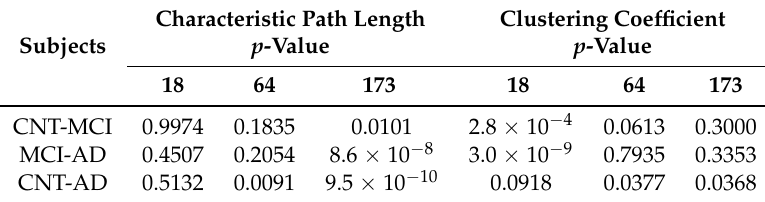
Table 2. Results of Tukey’s HSD post-hoc